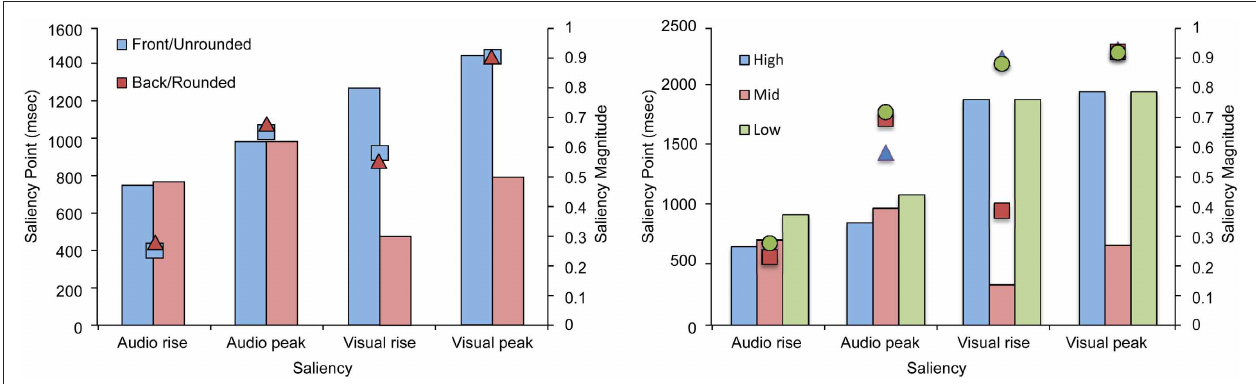
FIGURE 9 | Average saliency rise and peak (in ms) and saliency magnitude for each point for the audiovisual speech stimuli used in Experiment 3 as a function of the roundedness and